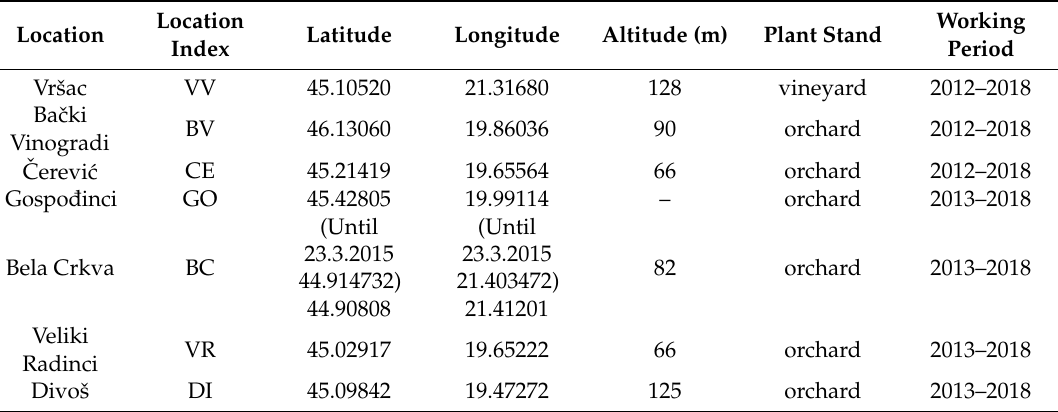
Table 1. Selected automatic weather stations in the PIS agrometeorological network.